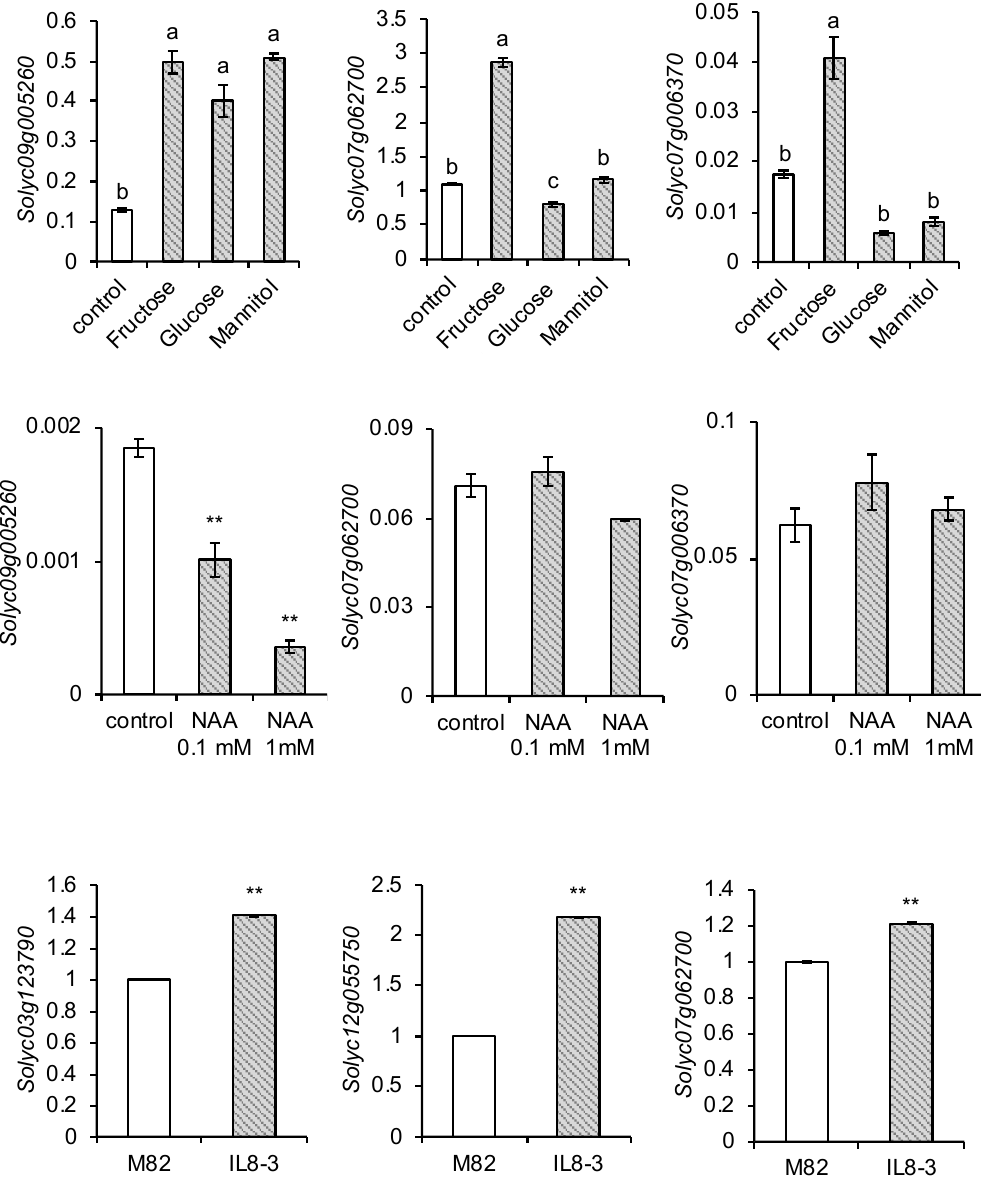
Figure 5. In the top two rows, the e ff ect of sugar and auxin (NAA) on gene expression is shown for Solyc09g005260 (SlCAX) , Solyc07g062700 (SlNCL) , and Solyc07g006370 (SlCCX) . Relative expression levels are shown, with error bars indicating the standard error of the mean of three biological replicates. Values with di ff erent letters are significantly di ff erent at P < 0.05 according to the Tukey–Kramer test. In the bottom rows, the expression of Solyc03g123790 (SlCAX) , Solyc12g055750 (SlCAX) , and Solyc07g062700 (SlNCL) is shown for fruits of parental tomato cultivar M82 and its near-isogenic line IL8-3 containing a chromosome segment from tomato’s wild relative. Relative expression levels from the microarray data [51] are shown, with error bars indicating the standard error of the mean of three biological replicates. ** P < 0.01 between M82 and IL8-3, as revealed by a t